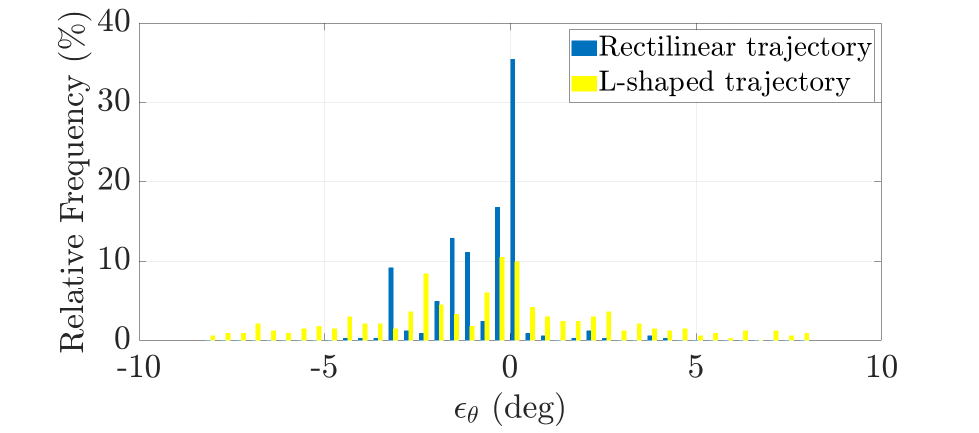
Figure 10. Histograms of the measured DoA error. Blue bars refer to rectilinear trajectories (726 sam- ple points), whereas yellow bars refer to L-shaped trajectories (668 sample